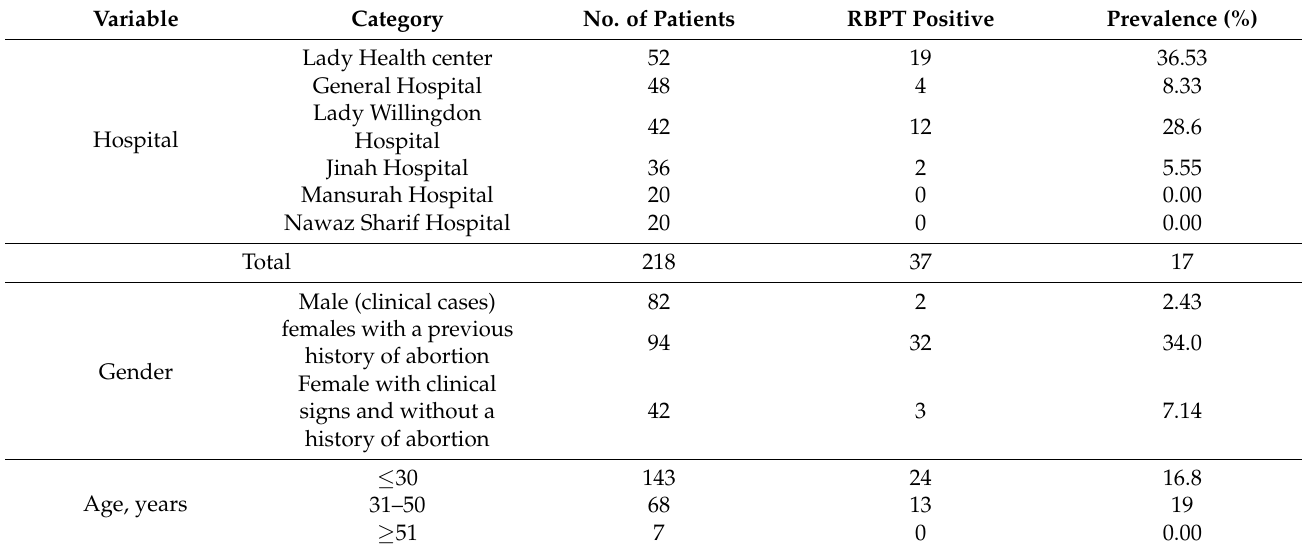
Table 1. Seroprevalence of brucellosis in 218 patients admitted to six hospitals of the Lahore district of Pakistan using RBPT.